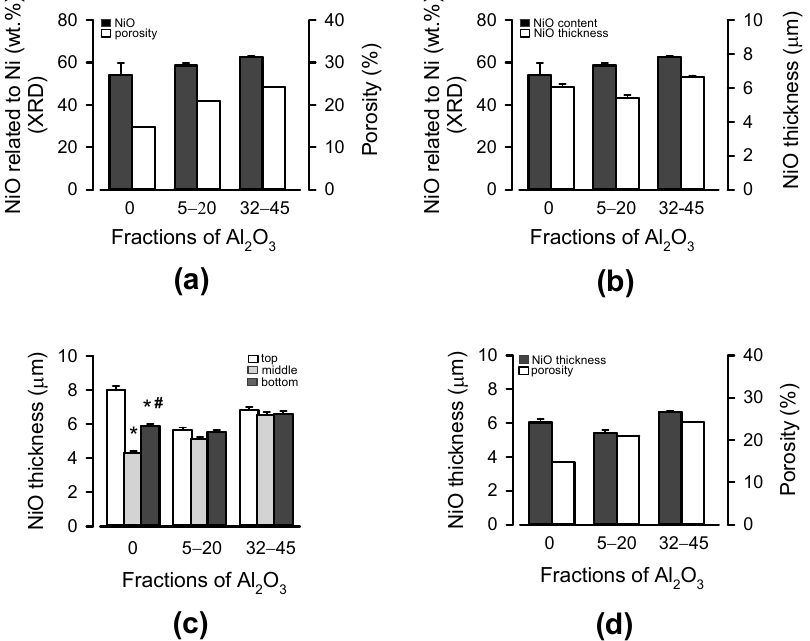
Figure 9. Correlation between NiO amount derived from XRD analysis and the open porosity ( a ) and NiO thickness ( b ); ( c ) NiO thickness measured in three distinct regions of Ni and Ni/Al 2 O 3 samples; ( d ) Correlation between NiO thickness and open porosity. NiO amount in ( a , b ) is related to the Ni content. * Significant versus the top position, significant # versus the middle position.